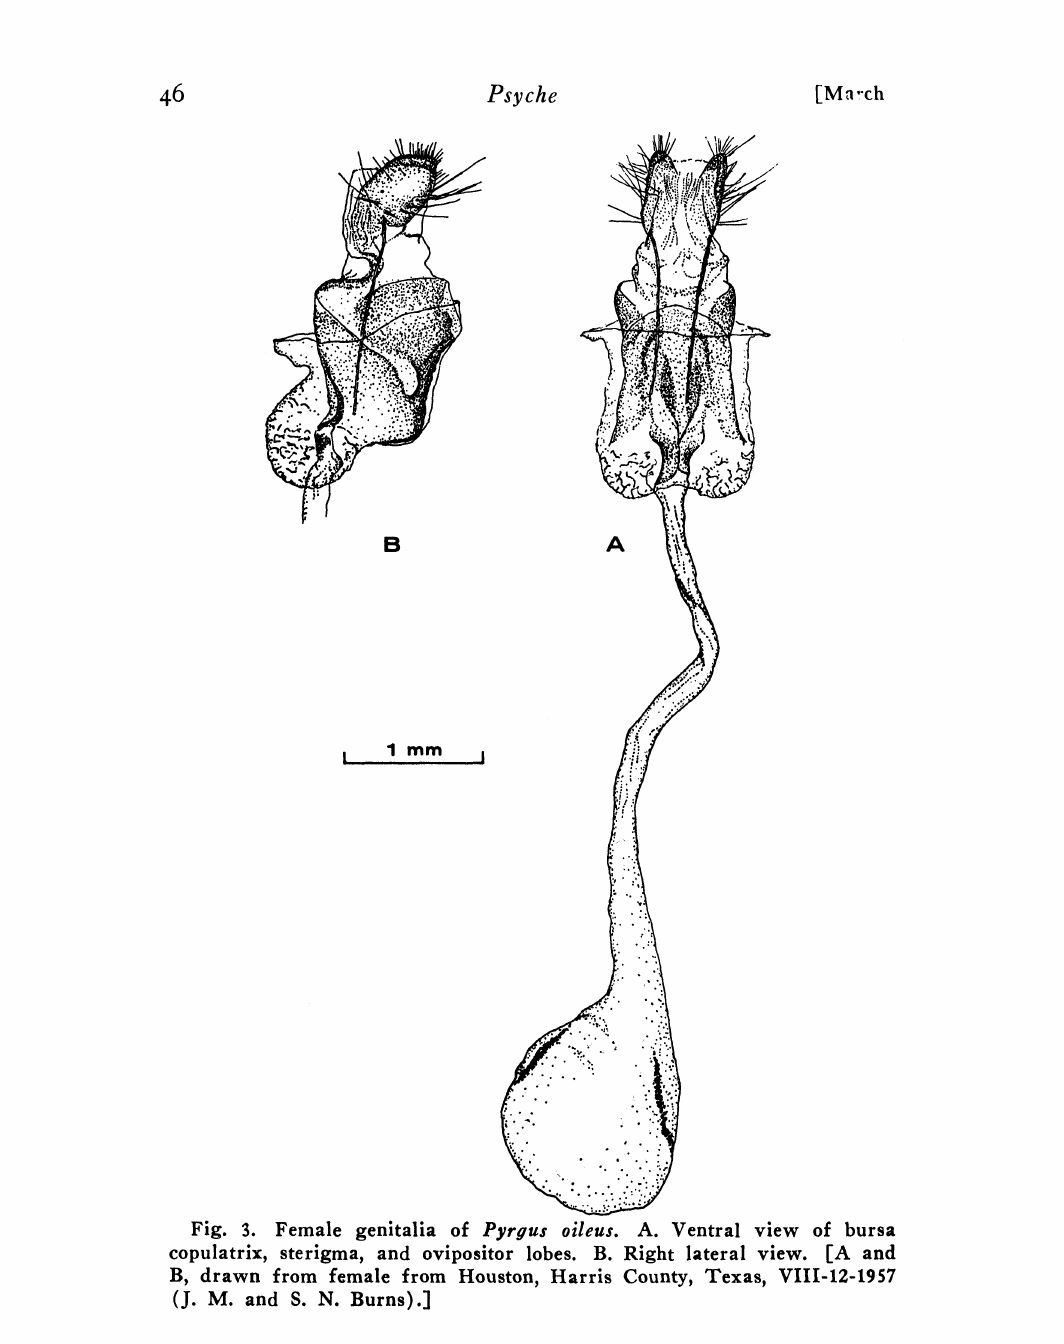
Fig. 3. Female genitalia of Pyrgus oileus. A. Ventral view of bursa copulatrix, sterigma, and ovipositor lobes. B. Right lateral view. [A and B, drawn from female from Houston, Harris County, Texas, VIII-12-1957 (J. M. and S. N.